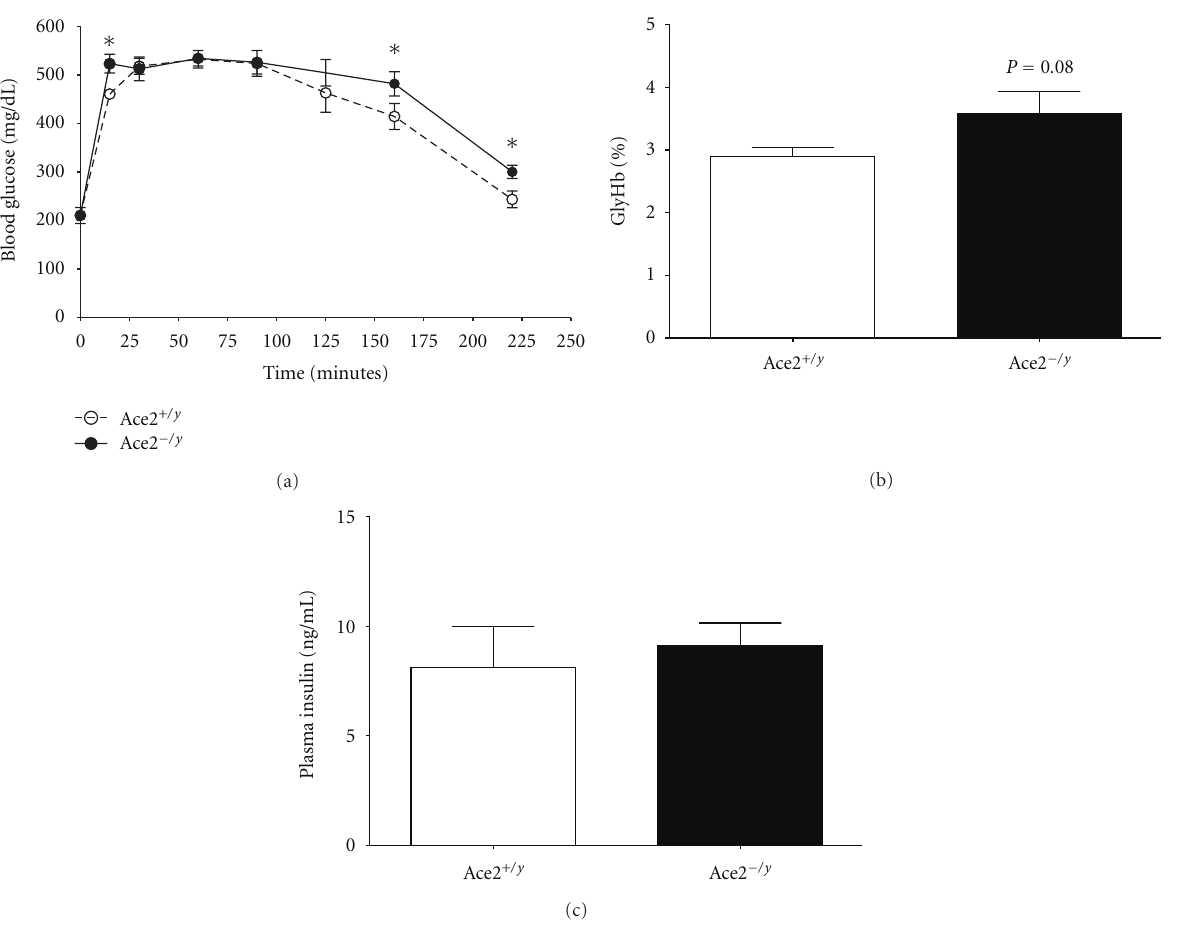
Figure 3: Bone marrow deficiency of ACE2 augments glucose intolerance at specific time points following glucose injection in HF-fed C57BL/6 mice. (a) Glucose tolerance tests (GTT) in HF-fed chimeric mice transplanted with bone marrow from Ace2 + /y or − /y mice. (b) Percent glycosylated hemoglobin levels and plasma insulin concentrations (c) in Ace2 + /y and − /y chimeric mice. Data are mean ± SEM from N = 8–15 mice/donor genotype. ∗ : P < 0 . 05 compared to Ace2 + /y